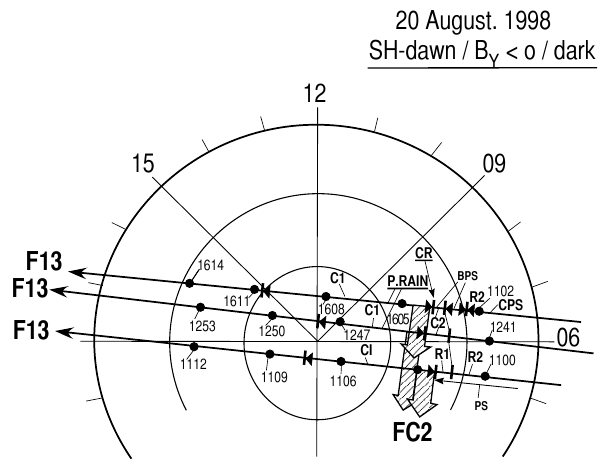
Fig. 9. Three DMSP F13 tracks across the polar cap in the Southern Hemisphere (SH) shown in MLT/MLAT coordinates. The event cat- egory is SH-dawn/ B y < 0 (dark). The following intervals are marked (i) 11:00–11:12, (ii) 12:41–12:53, and (iii) 16:02–16:14UT. Con- vection channels are marked by hatched arrows. Particle precipita- tion (CPS, BPS, P.RAIN) and Birkeland current regimes (R2, R1, C2, C1) are marked along the different